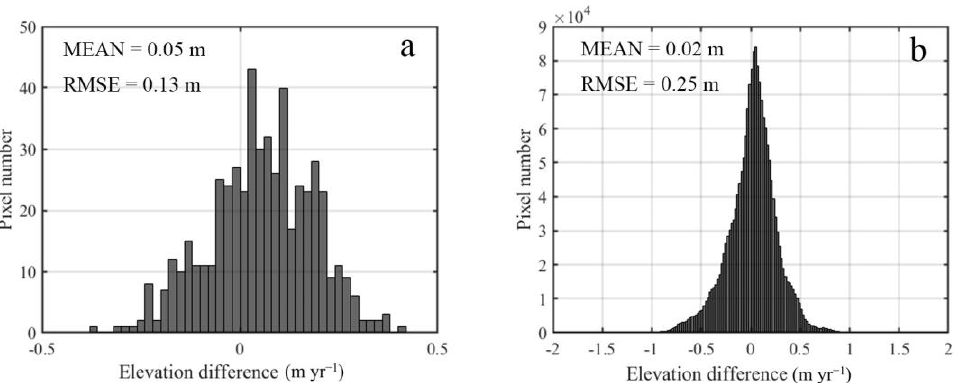
Figure 2. The deviation histogram of vertical errors of surface elevation change in 2000 – 2016 ( a ) and in 2020 – 2021 ( b ) over the off-glacier